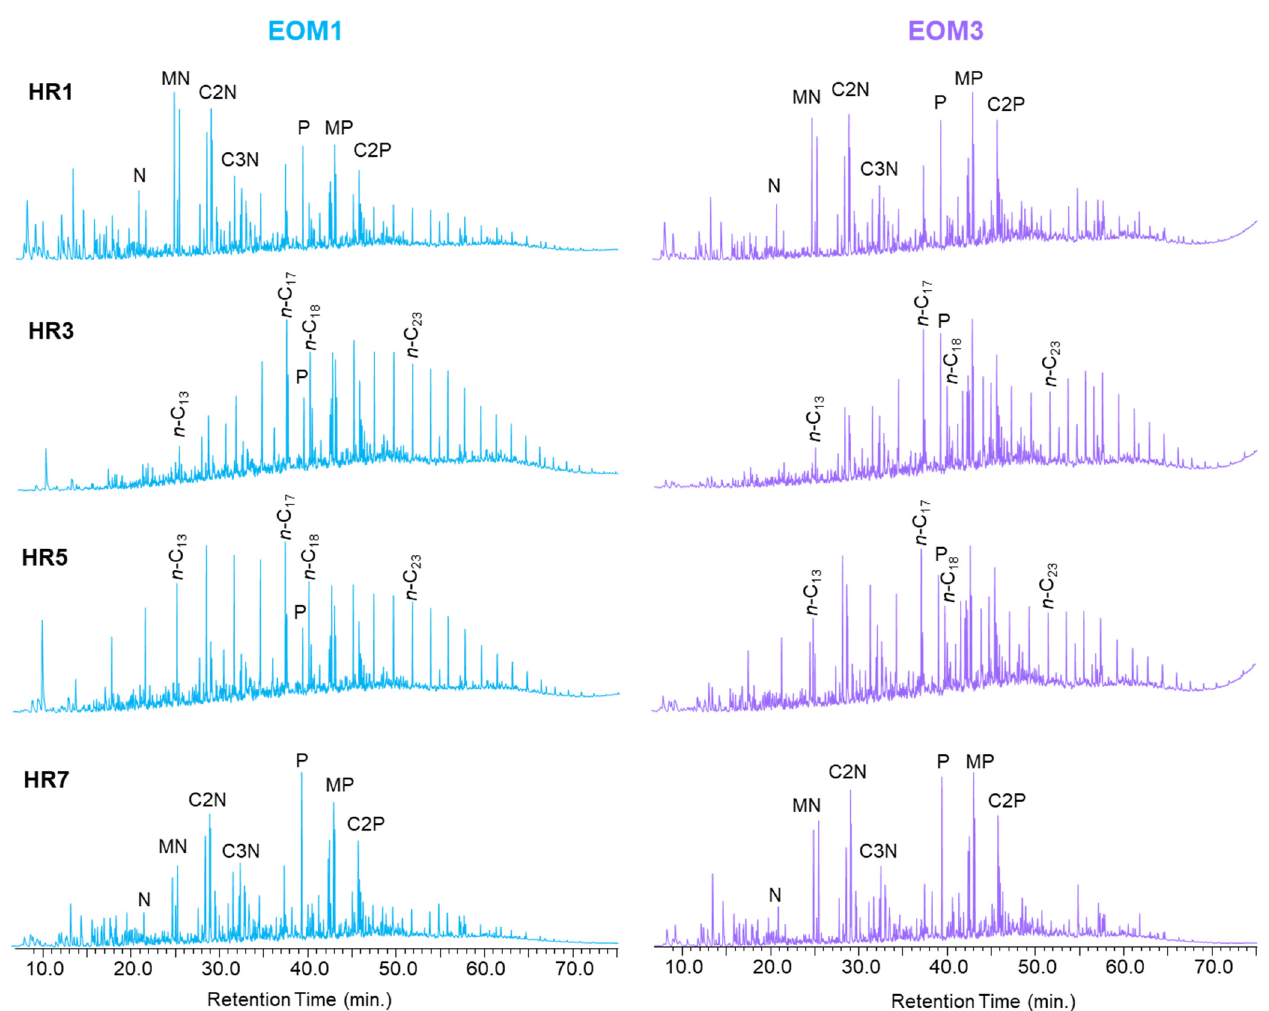
Figure 6. Total ion chromatograms (TIC) of the total hydrocarbon fraction from the EOM-1 and EOM-3 in representative samples. 13–23: carbon number of n -alkanes; N: naphthalene; MN: methylnaphthalenes; C2N: ethylnaphthalenes + dimethylnaphthalenes; C3N: trimethylnaphthalenes; P: phenanthrene; MP: methylphenanthrenes; C2P: ethylphenanthrenes + dimethylphenanthrenes.